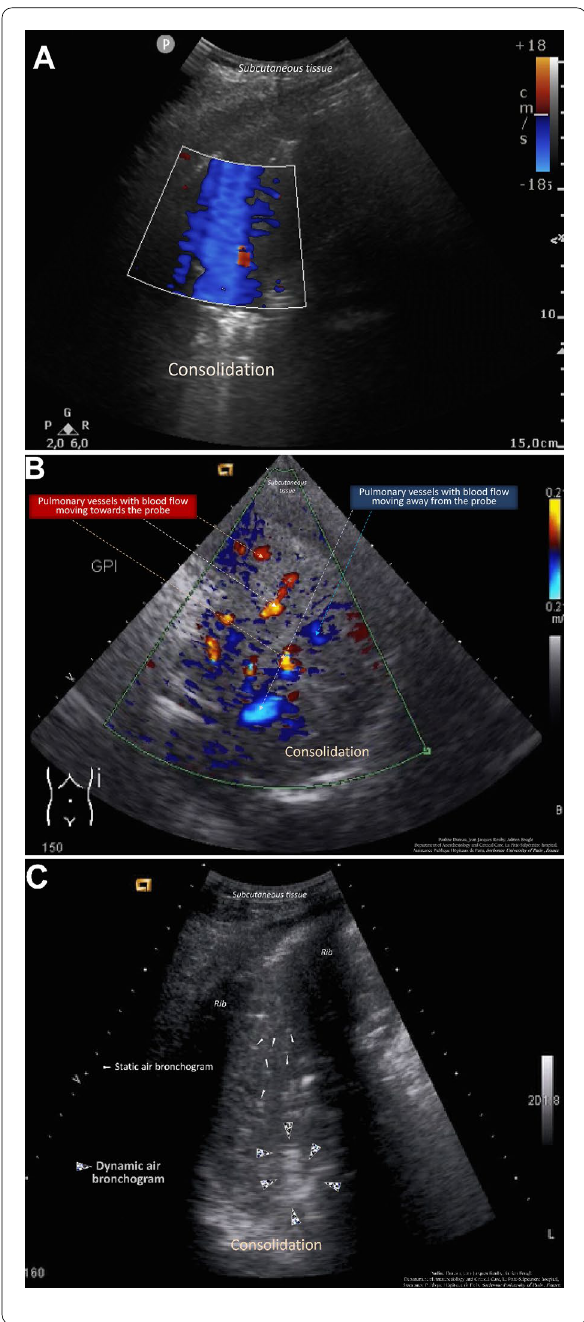
To assess to what extent LUS is as sensitive as chest radiography to screen VA ECMO patients for HAP, we used the simplified Clinical Pulmonary Infection Score (sCPIS) (Additional file 4: Table S3) described by Luna et al. [19] and the Lung ultrasound-simplified Clini- cal Pulmonary Infection Score (LUS-sCPIS) described previously in cardiac surgery patients (Additional file 4: Table S4). In this score, the "chest radiography" crite- rion is replaced by an ultrasound criterion, the pres- ence or not of a color Doppler intrapulmonary flow within a consolidation. The presence of a color Doppler intrapulmonary flow counts for two points [12].